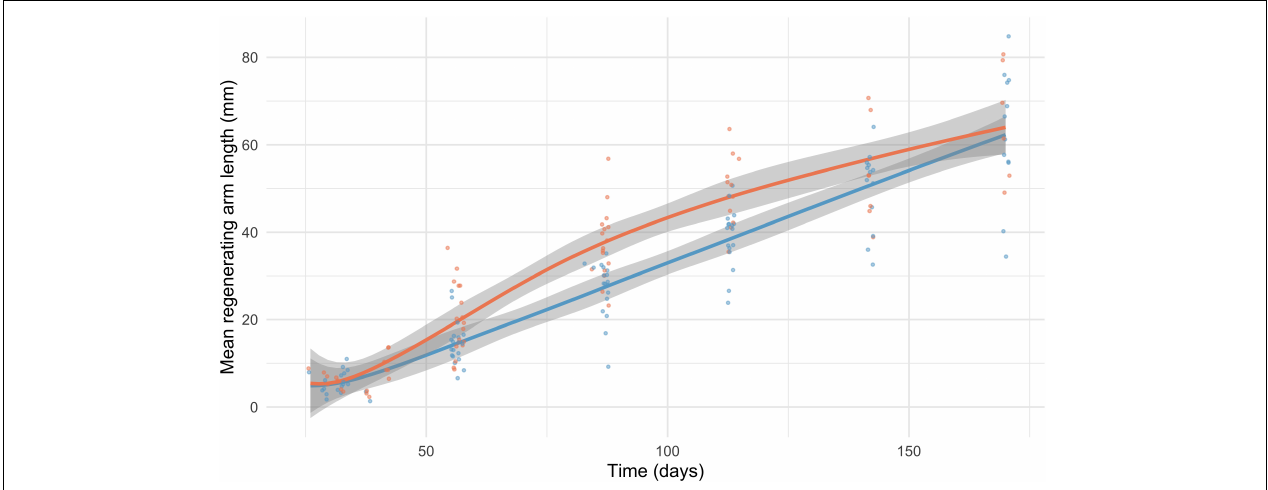
FIGURE 2 | Regenerating arm length over time of temperate swimming feather star, Florometra serratissima , exposed to ambient (blue, 9.8 o C) and warm (red, 12 o C) treatments in the lab. The 95% confidence interval of each curve is shown.